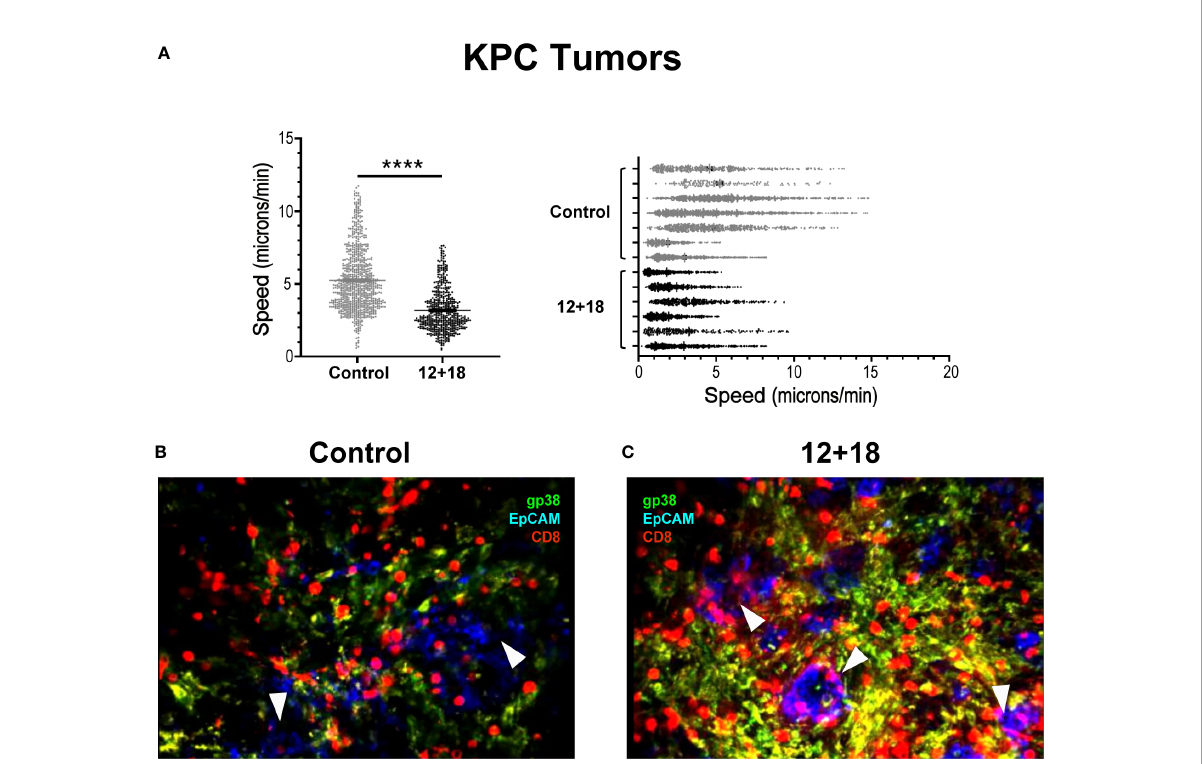
FIGURE 9 Effects of IL-12 plus IL-18 systemic expression on the behavior of tumor in fi ltrating CD8 + T cells from OT-I mice. OVA neg KPC- bearing C57BL/6 OT-I mice were hydrodynamically injected (HI) with IL-12 plus IL-18 cDNA (12 + 18) or empty cDNA as controls. After 7 days post-HI mice were euthanized, and tumors were harvested. Tumors were immediately included in a 5% agarose solution. Slides were made of 200µm using a Leica VT 1000S Vibratome and were stained with anti-CD8 (red), anti-gp38 (green) for stroma detection, anti-EpCAM (blue) for detecting epithelial (tumoral) cells. Time lapse images were taken every 30 seconds for 20 minutes with a DM500B upright microscope equipped with a SP5 confocal head (Leica) and a 37°C thermostated chamber. (A) Graph shows the speed mean (microns/min) of each individual CD8 + T cell across all the mice (left graph) or from each mouse individually (right graph) with the average speed corresponding to each experimental group (mean ± SEM). (B, C) Images selected from two representative movies obtained from (B) control or (C) 12 + 18 KPC tumors show the in fi ltrate and distribution of CD8 + T cells. Statistical analysis was performed by Student T test with Mann-Whitney correction (left C ). Values of ****p<0.0001 were consider signi fi